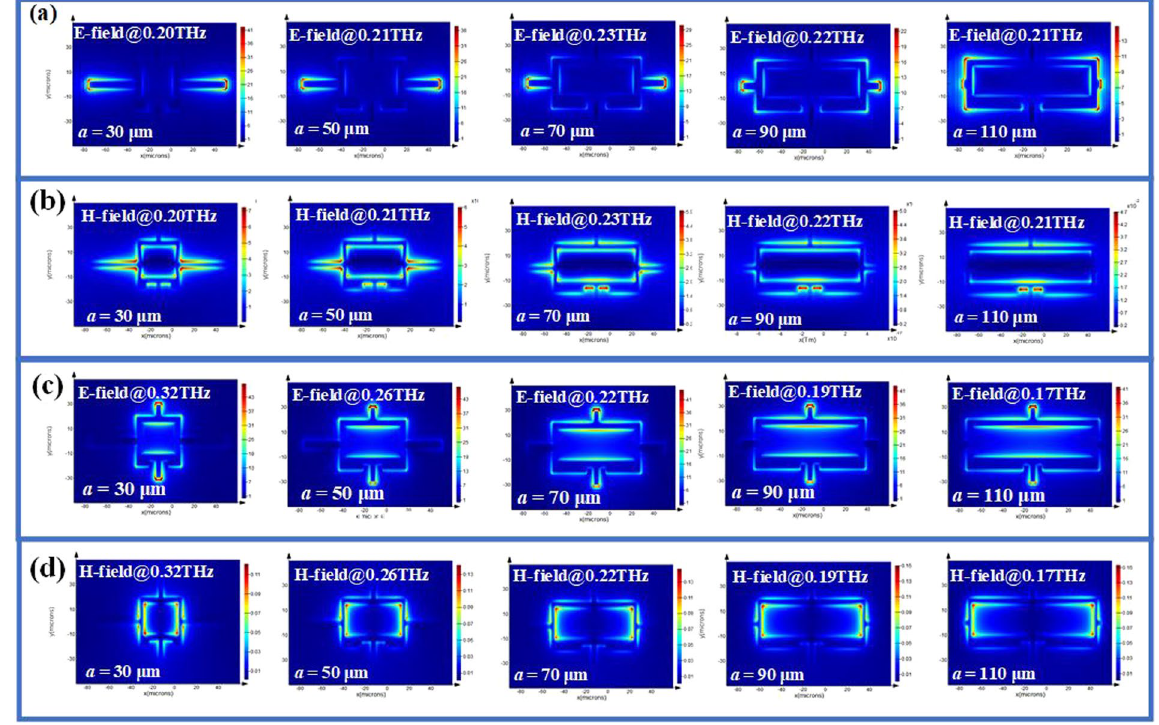
Figure 3. Electromagnetic field distributions of CLM with different a value. Electromagnetic field distributed images of CLM with different a value at ( a ) and ( b ) TE mode; ( c ) and ( d ) TM mode, where ( a ) and ( c ) are E-field distributions, while ( b ) and ( d ) are H-field distributions. (Symbol @ indicates the corresponding monitored frequency).